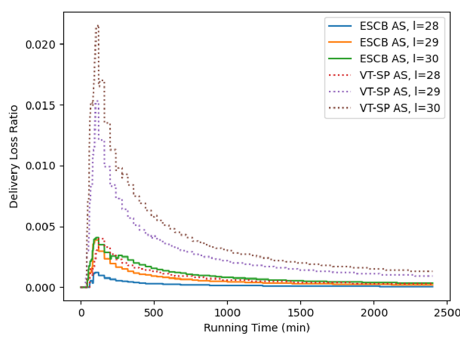
Figure 11. Delivery loss ratio for access services.